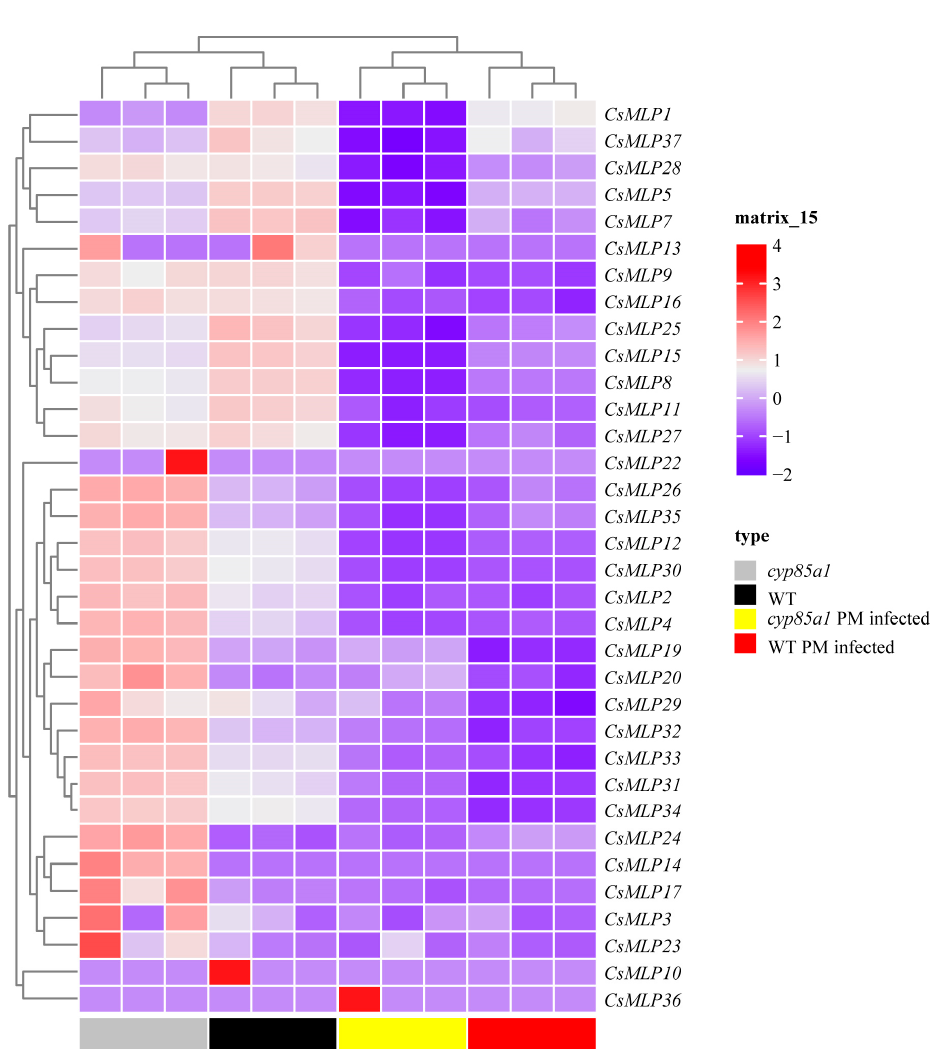
Figure 5. Heat map diagrams of 37 CsMLP genes expression. Heatmap colors represent the gene expression (shown as absolute normalized RPKM values).